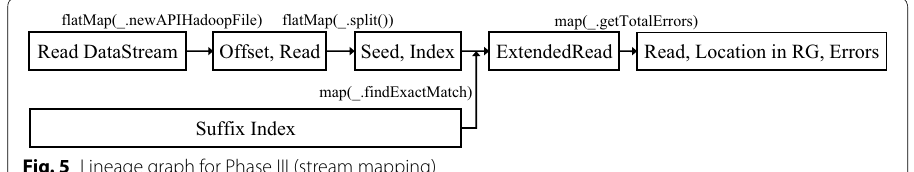
Fig. 5 Lineage graph for Phase III (stream